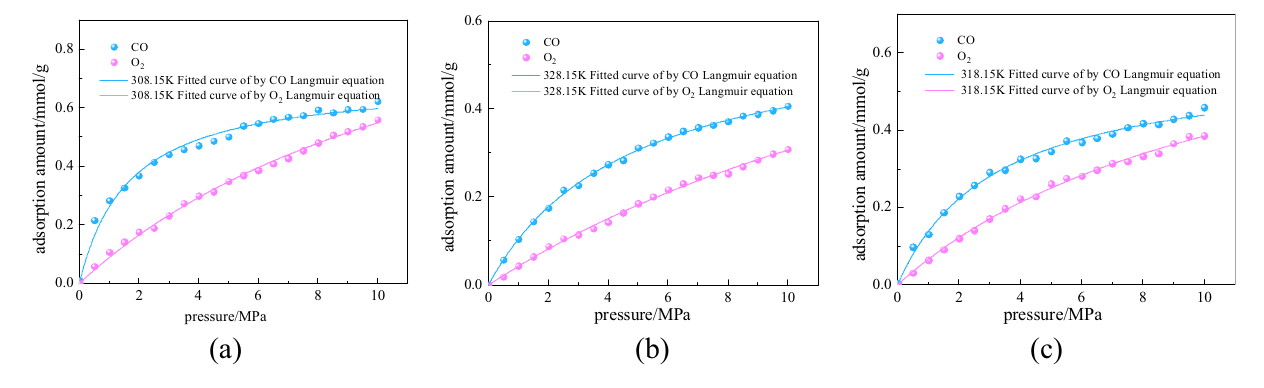
Figure 6. Adsorption isotherms of CO and O 2 at different temperatures.